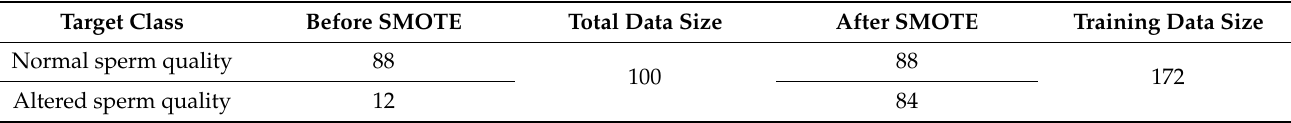
Table 4. Handling imbalanced classes using